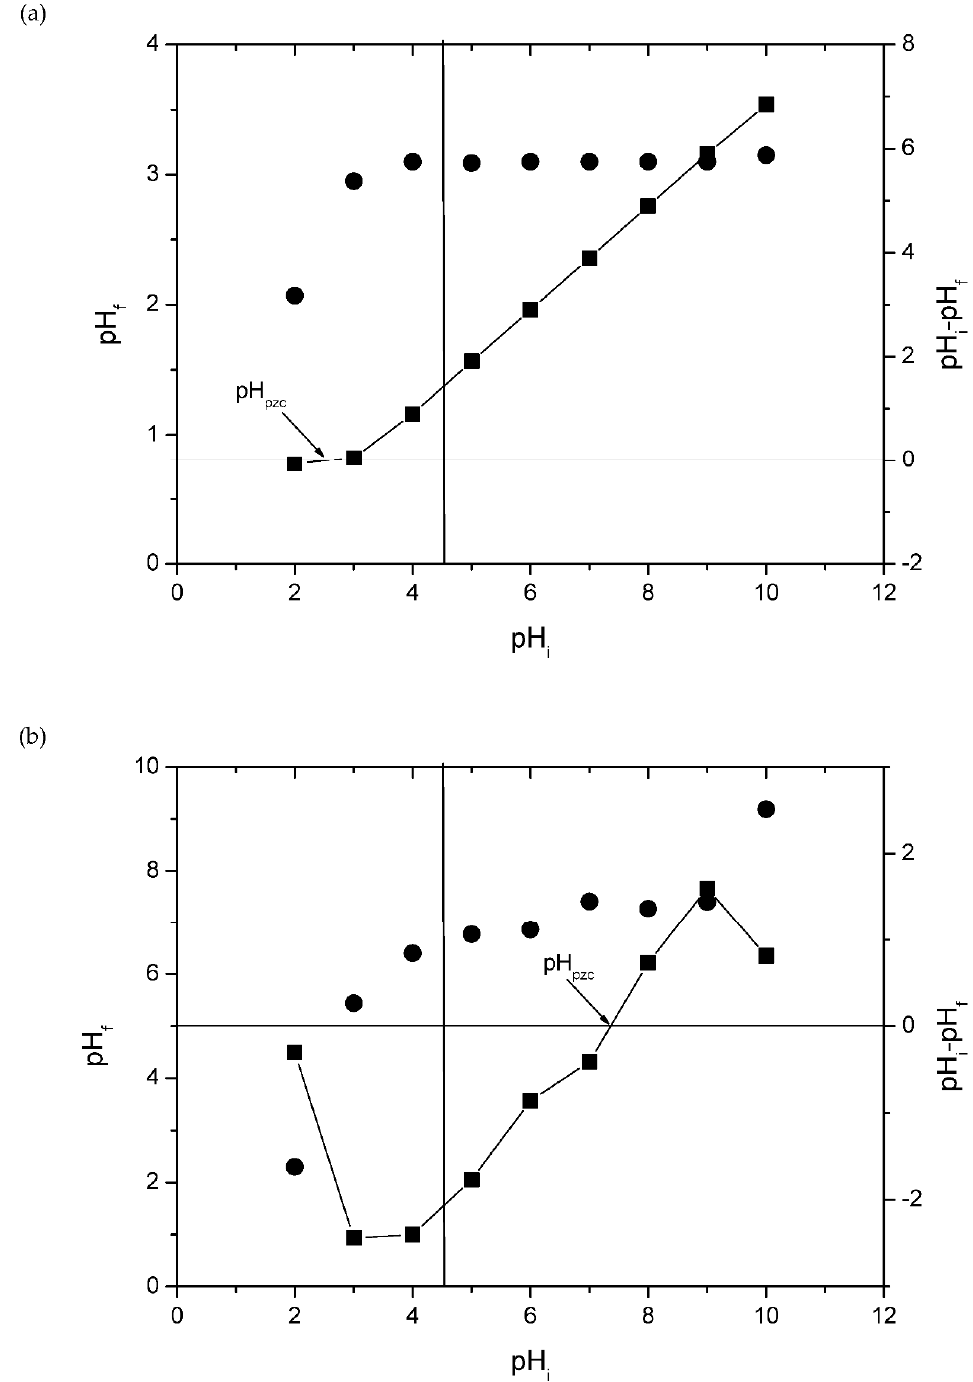
Figure 3. The pH pzc of ( a ) MHAF-SA hydrogel beads and ( b ) MHAF-CS hydrogel beads.